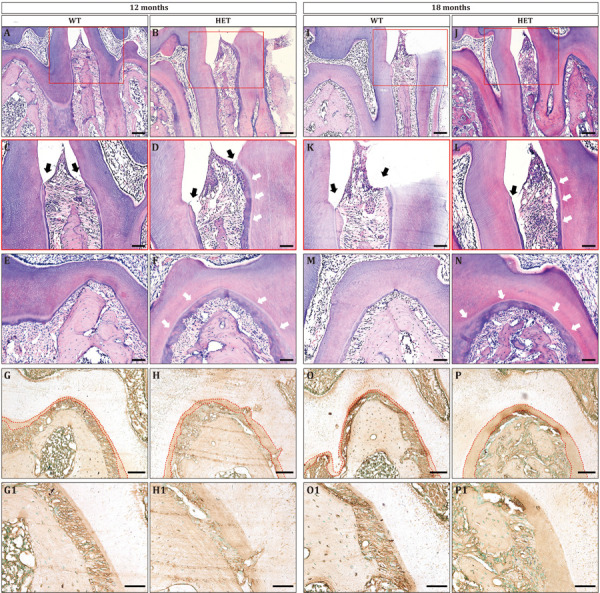
Periodontitis and cementum hyperplasia could be found in Dspp heterozygous mice at the ages of 12 months (A–H) and 18 months (I–P). (A,B,I,J) Sagittal sections of the interdental septum between the mandibular first molars and the mandibular second molars. Scale bar = 100 μm. (C,D,K,L) Enlarged images of the red boxes in (A,B,I,J), respectively. Black arrows indicated the level of epithelial attachment and the bottom of the gingival sulcus. White arrows pointed to the thickened cementum. Scale bar = 50 μm. (E,F,M,N) Furcation areas of the mandibular first molars. Scale bar = 50 μm. (G,H,O,P) Immunohistochemical staining for BSP at the furcation areas, with red dotted lines illustrating the area of the cementum. (G1,H1,O1,P1) are the high magnification images of G,H,O,P, respectively. For each group, n = 3. Scale bars = 50 μm.